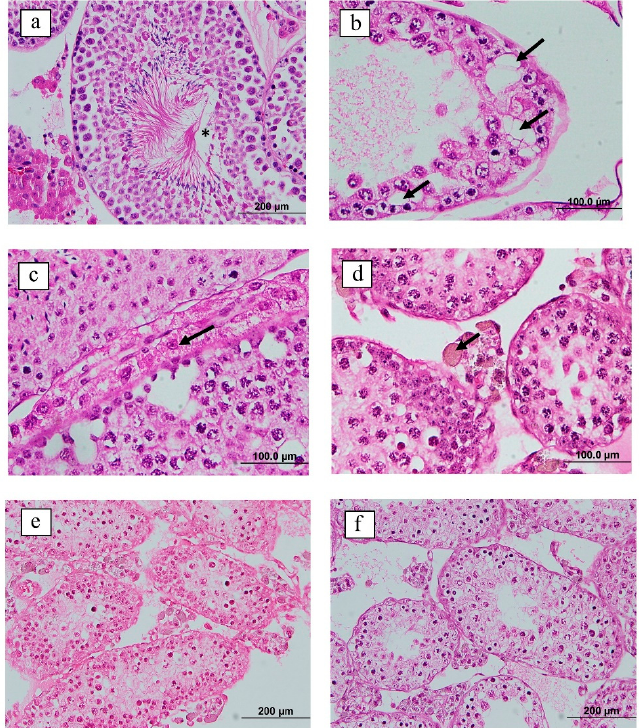
Figure 4. Cross-sections of testis from vaccinated and control mice in week 24. ( a ) Control group: normal testis with normal seminiferous tubules; the lumen (*) is visible, and sperm head coverage is over 80% (hematoxylin and eosin stain, 200 × ). ( b ) Vaccinated group: multifocal germinal epithelium and Sertoli cell degeneration. Seminiferous tubule vacuolation is seen (arrow; hematoxylin and eosin stain, 400 × ). ( c – f ) Vaccinated group (hematoxylin and eosin stain, 400 × ) with ( c ) Leydig cells showing gross degenerative changes (arrow); ( d ) brown pigment accumulation in the cytoplasm of Leydig cells (arrow); ( e ) seminiferous tubule degeneration, absence of sperm in the lumen, and germ cell degeneration and depletion; ( f ) disorganized germinal epithelium with few sperm and germ cell degeneration and